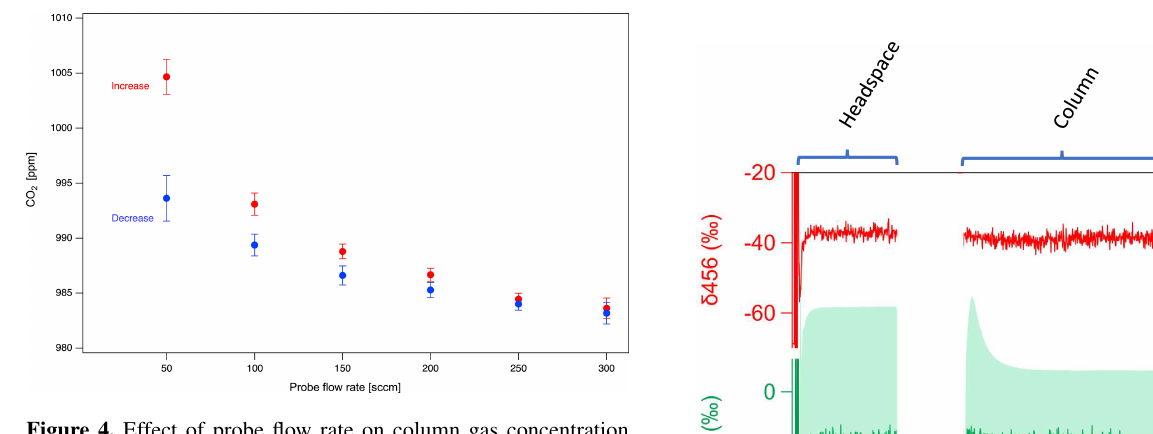
Figure 4. Effect of probe flow rate on column gas concentration (System 1), representing the potential impact of probe sampling on the soil environment. Points represent concentration of CO 2 in the headspace column for 1h after a 15min probe sampling event at various increasing (forward) and decreasing (reverse) probe sam- pling flow rates.